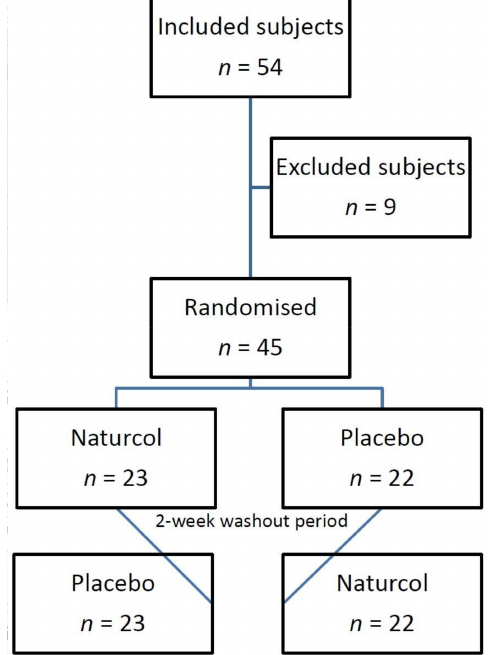
Figure 1. Flowchart of the study